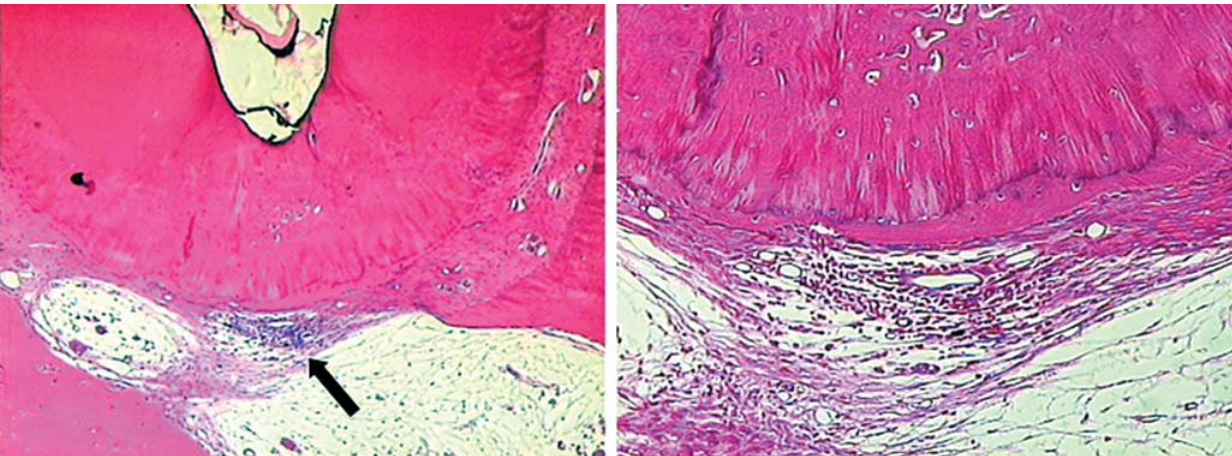
FIGURE 3 - A - SEM micrograph of apical and periapical regions of a specimen belonging to the RoekoSeal group. Note inflammatory infiltrate along apical periodontal ligament (arrow). HE. 40X. B - Close-up view. Mononuclear inflammatory reaction can be observed, compatible with score 3 of AIR. H&E.